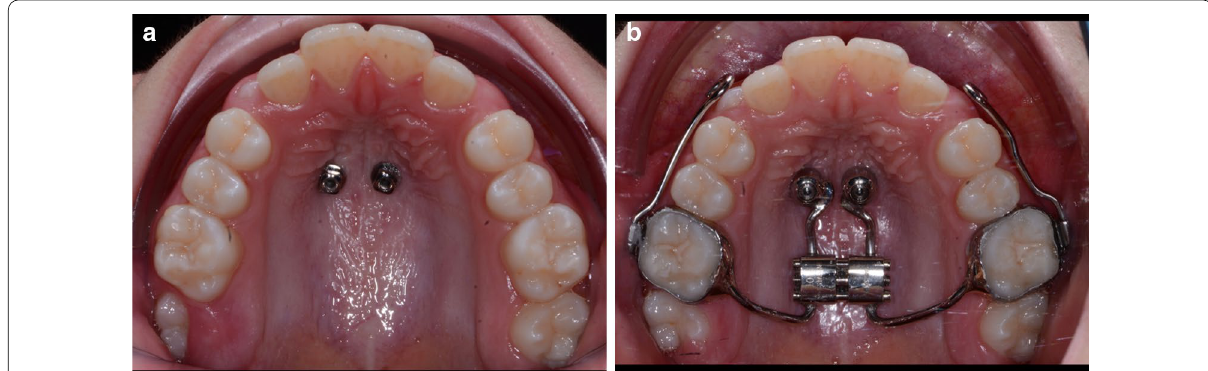
Fig. 2 a , b SKAR III orthodontic